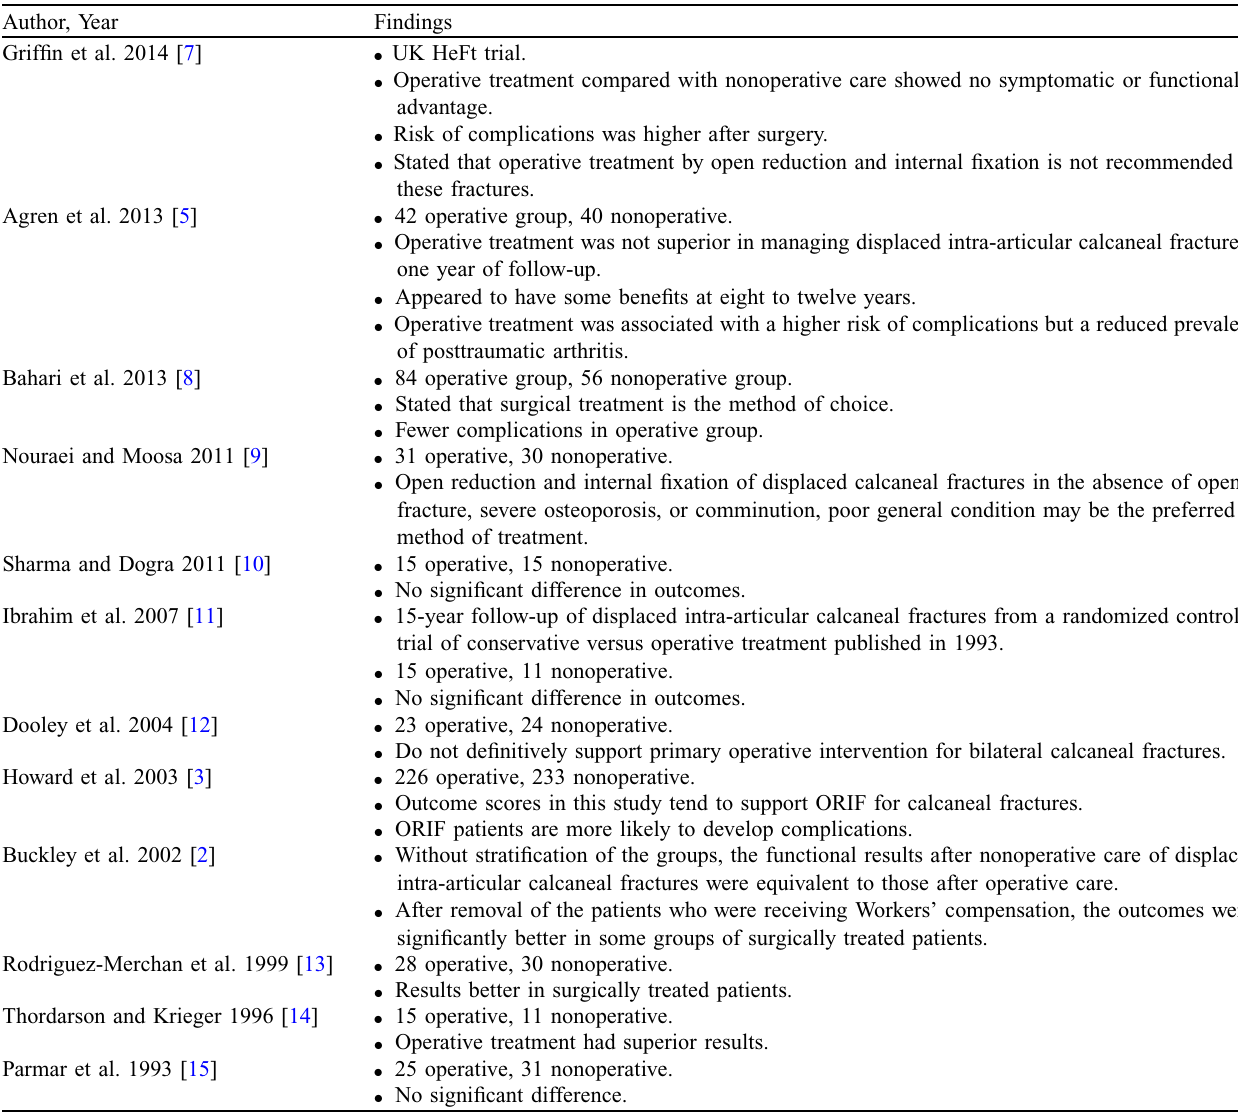
Table 1. Overview of existing randomized controlled trials on operative vs nonoperative treatment of calcaneus